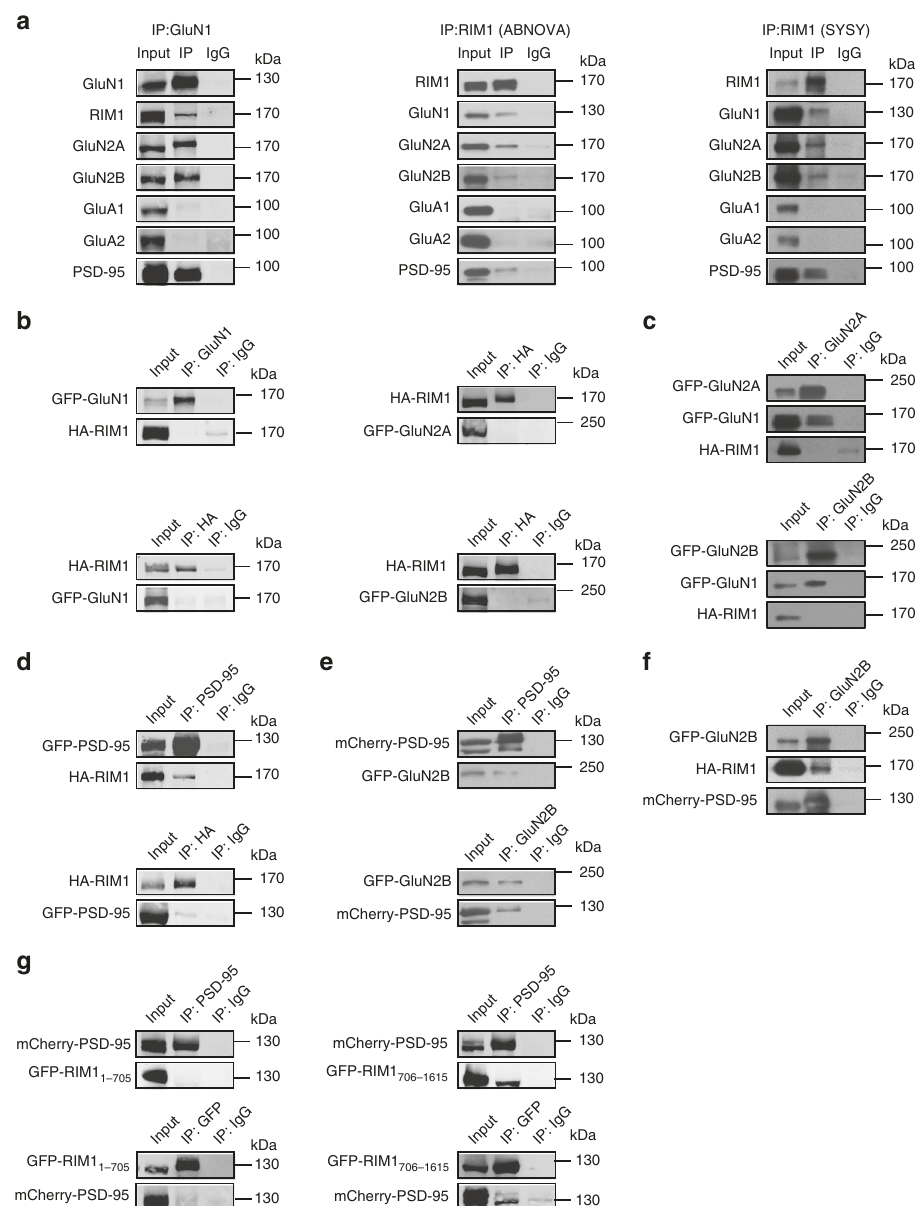
Fig. 5 RIM1 is a binding partner of the NMDAR complex in mouse brain. a RIM1 is within the NMDAR complex, but not the AMPAR complex. Extracts from adult mouse cortex were immunoprecipitated with antibodies against GluN1 (left) or RIM1 (middle: antibody from ABNOVA; right, antibody from SYSY) and blotted with corresponding antibodies. IP immunoprecipitation. b RIM1 has no interaction with NMDAR subunits in transfected HEK293T cells. Extracts of HEK293T cells transfected with HA-RIM1 and GFP-GluN1 (left), GFP-GluN2A (upper right), or GFP-GluN2B (lower right) were immunoprecipitated with GluN1 or HA antibody and blotted with the corresponding antibodies. c Extracts of HEK293T cells co-transfected with HA-RIM1, GFP-GluN1, and GFP- GluN2A (upper), or HA-RIM1, GFP-GluN1, and GFP-GluN2B (lower) were immunoprecipitated with GluN2A or GluN2B antibody and blotted with the corresponding antibodies. d RIM1 interacts with PSD-95 in transfected HEK293T cells. e GluN2B interacts with PSD-95 in transfected HEK293T cells. f Extracts of HEK293T cells co-transfected with HA-RIM1, GFP-GluN2B, and mCherry-PSD-95 were immunoprecipitated with GluN2B antibody and blotted with the corresponding antibodies. g Different RIM1 fragments tagged with GFP (GFP-RIM1 1-705 or GFP-RIM1 706-1615 ) were cotransfected with mCherry- PSD-95 into HEK293 cells and the interaction between these two proteins was tested by immunoprecipitation RIM1 is a binding partner of the NMDAR complex . We used signi fi cant difference between groups in freezing responses immediately after training (control RNAi, 24.3 ± 4.1%, n = 10 mice; RIM1 RNAi, 25.9 ± 5.0%, n = 10 mice; p > 0.05; Fig. 4k), suggesting that RIM1 KD does not impair the shock-induced freezing response. However, RIM1 KD mice showed a signi fi cant reduction in the time spent freezing at 24 h after conditioning (control RNAi, 39.5 ± 5.3%, n = 10 mice; RIM1 RNAi, 22.5 ± 4.3%, n = 10 mice; p < 0.05; Fig. 4l), indicating an impairment in contextual fear memory. GluN1, GluN2A, and GluN2B, but not the AMPAR subunits | DOI: 10.1038/s41467-018-04672-0 |